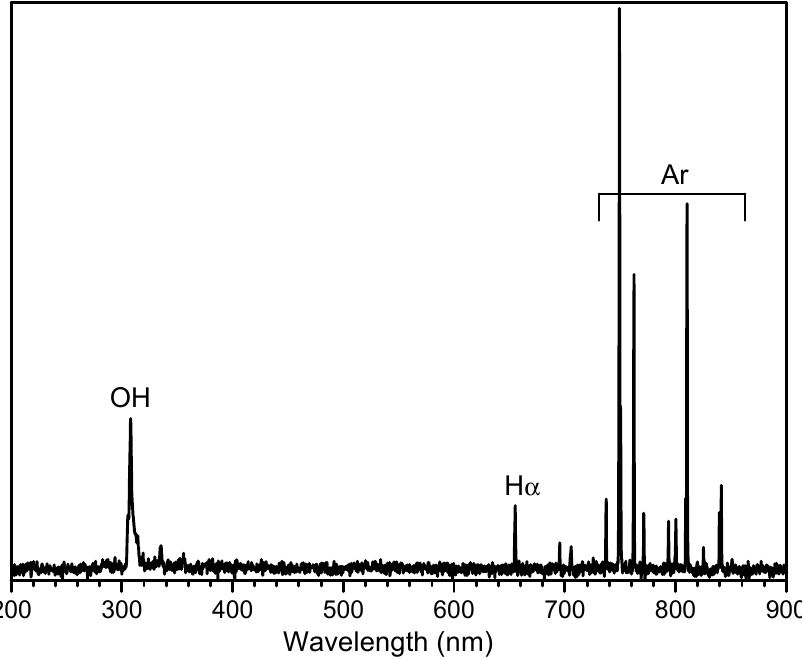
Figure 4. OES of the pulsed discharge plasma that was applied to the liquid water surface.